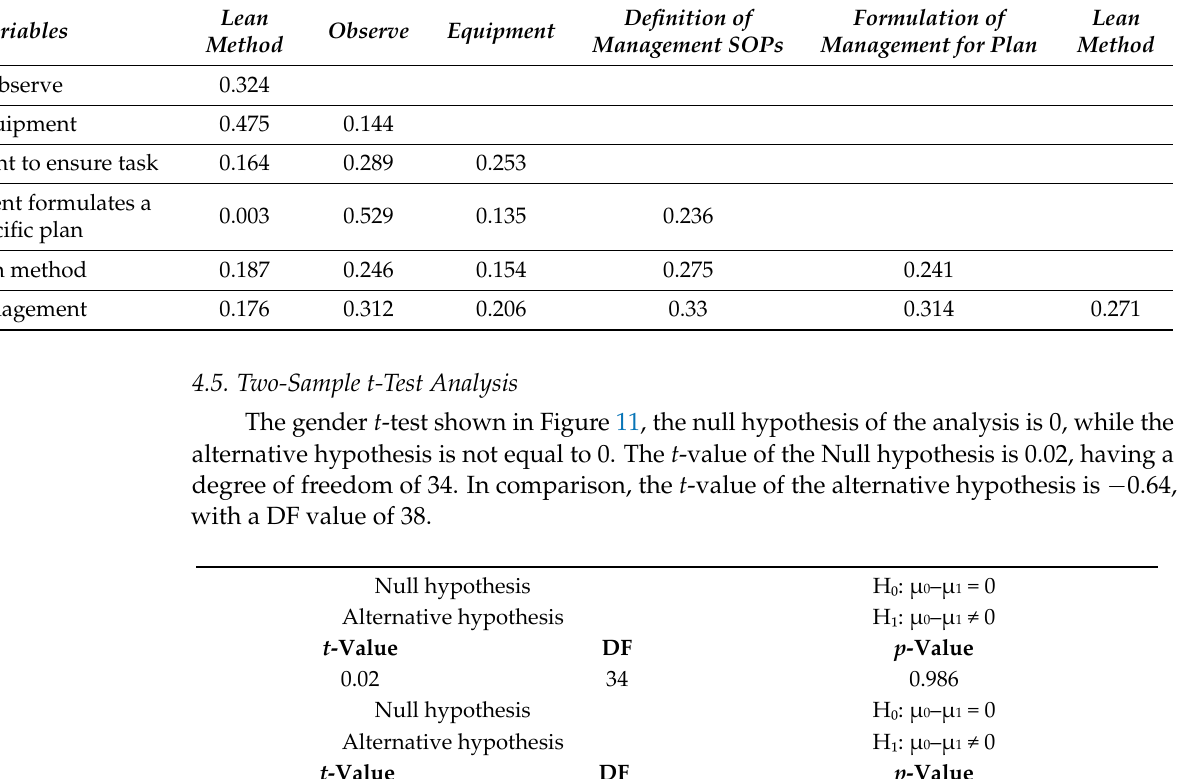
Table 9. Lean correlation with variables.